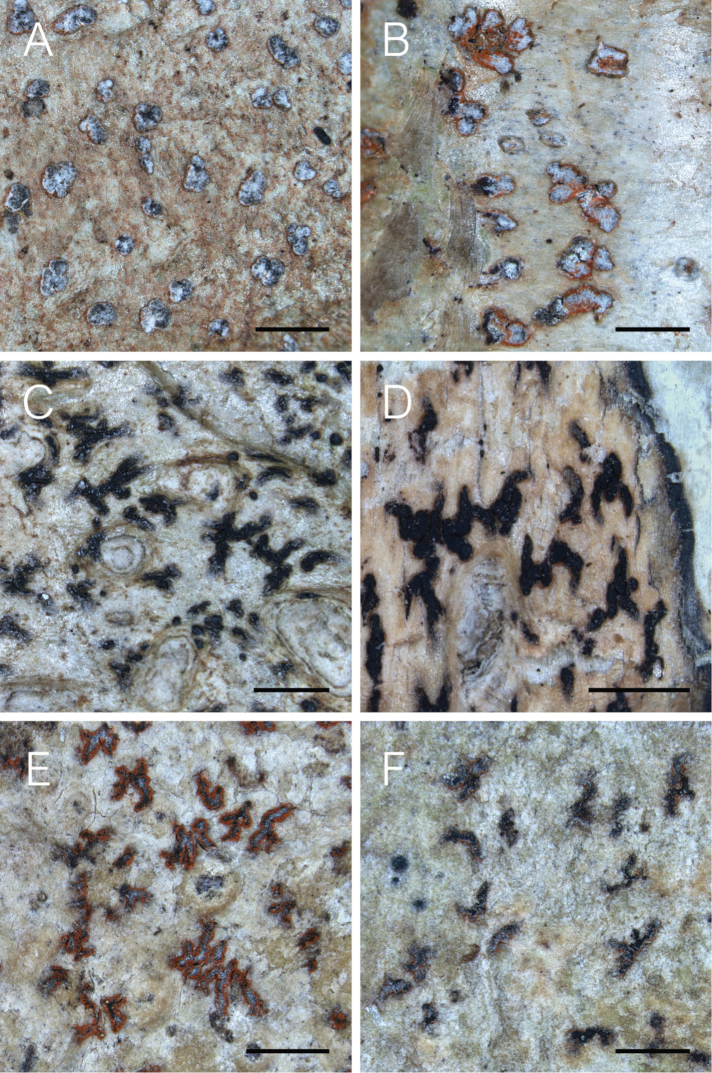
Morphological diversity of Coniocarpon in Norway. AConiocarpon
cinnabarinum (Frisch TRH-L-29000) BConiocarpon
cinnabarinum (Frisch TRH-L-29005) CConiocarpon
cuspidans (TRH-L-29022) DConiocarpon
cuspidans (TRH-L-29023) EConiocarpon
fallax (TRH-L-16793) FConiocarpon
fallax (Frisch TRH-L-29028). Scale bars: 1 mm.